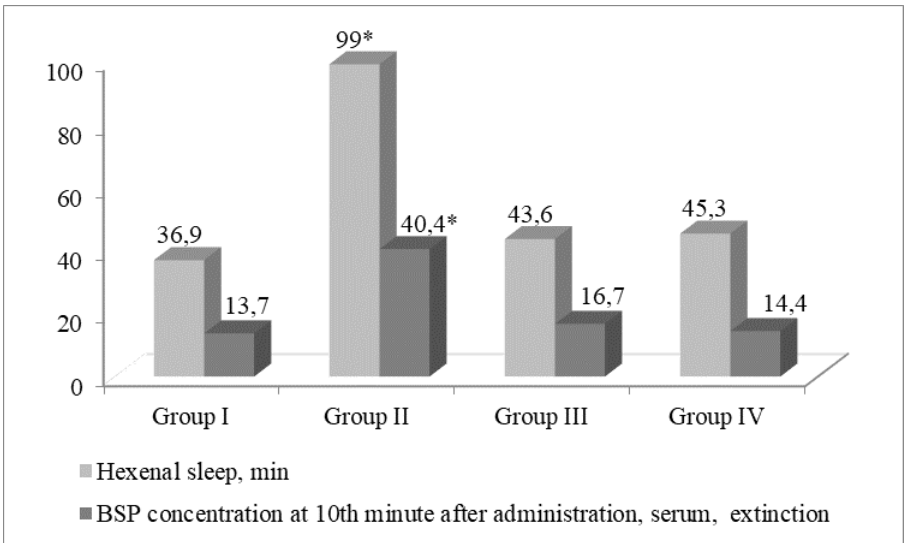
Figure 4. Liver function in CCl4-intoxicated rats and in animals treated with Acyzol and Silymarin. Notice. *—significant differences compared to intact animals at р < 0.05. group I—intact. group II received equivalent amount of distilled water. group III received Acyzol at a dose of 10 mg / kg